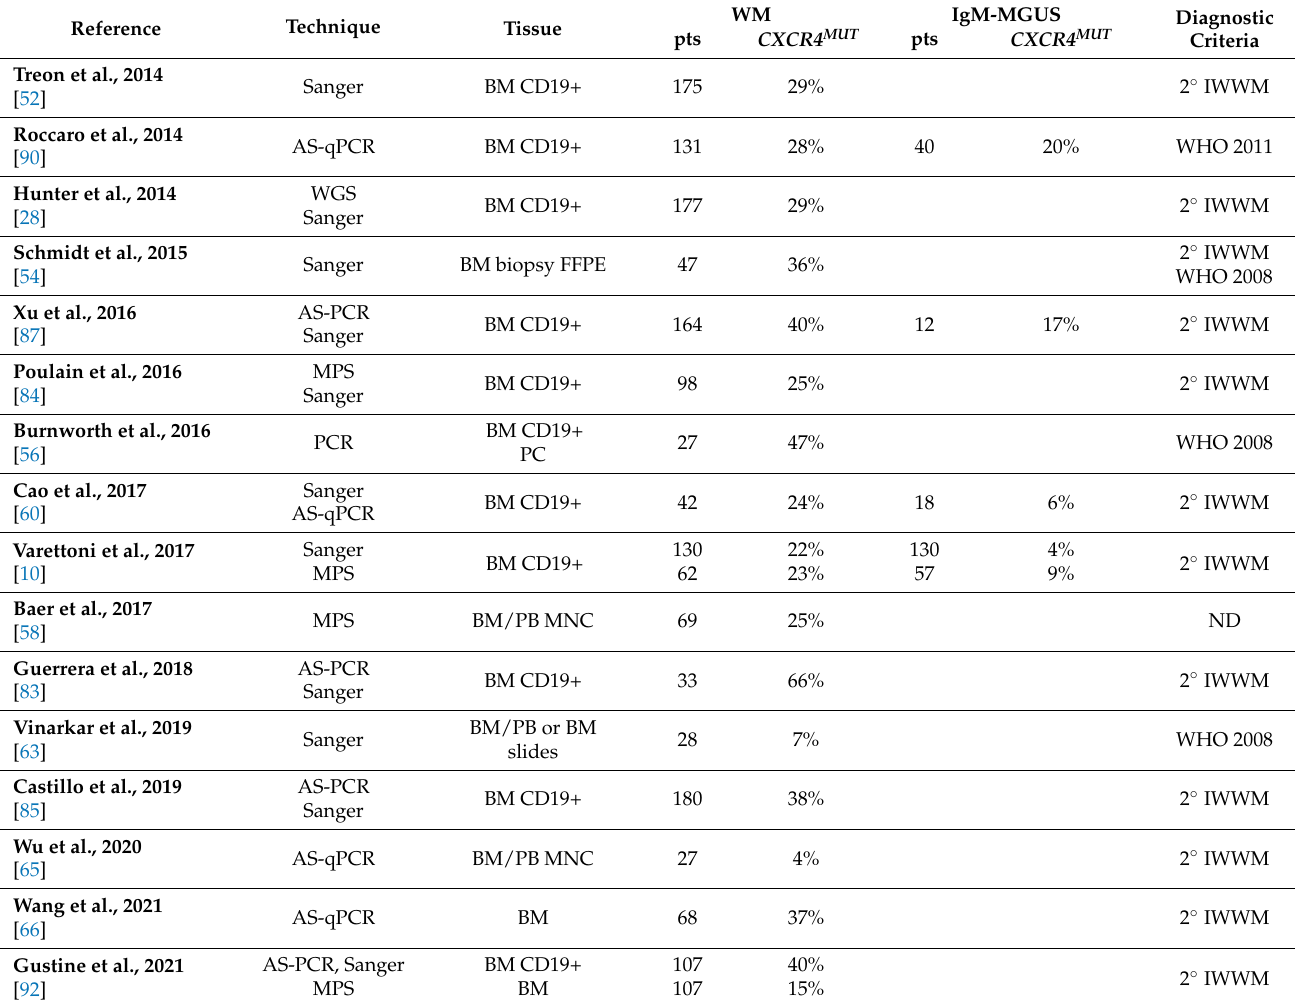
Table 2. CXCR4 detection in WM and IgM-MGUS. pts: patients; WM: Waldenström macroglobu- linemia; MGUS: monoclonal gammopathy of undetermined significance; BM CD19+: bone marrow CD19+ selected cells; FFPE: formalin-fixed paraffin-embedded; AS-PCR: allele-specific polymerase chain reaction; AS-qPCR: allele-specific quantitative PCR; MPS: massively parallel sequencing; MNC: mononuclear cell; BM: bone marrow; PC: plasma cells; PB: peripheral blood; ES: effect size measured by random-effects